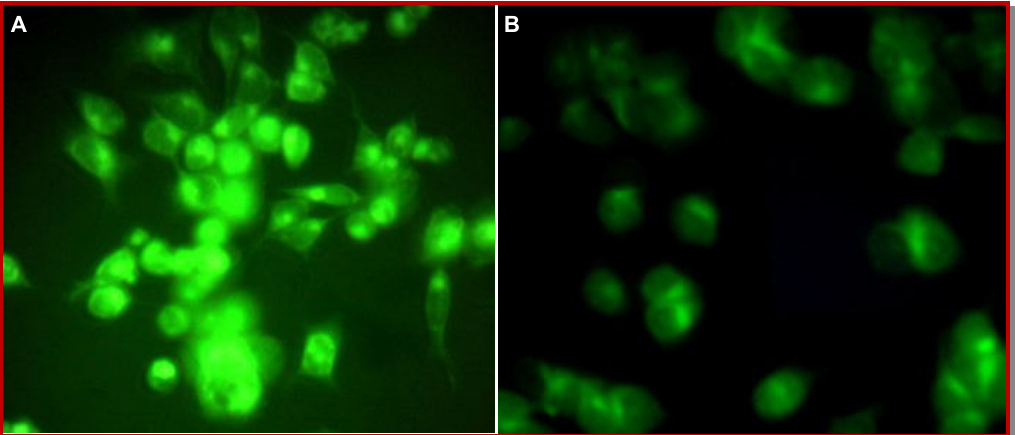
Figure 3: Permeability in Z. decandra- treated cells (B) when compared with control cells (A) using rhodamine-123